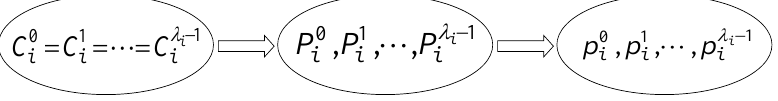
Figure 2: The relationship of